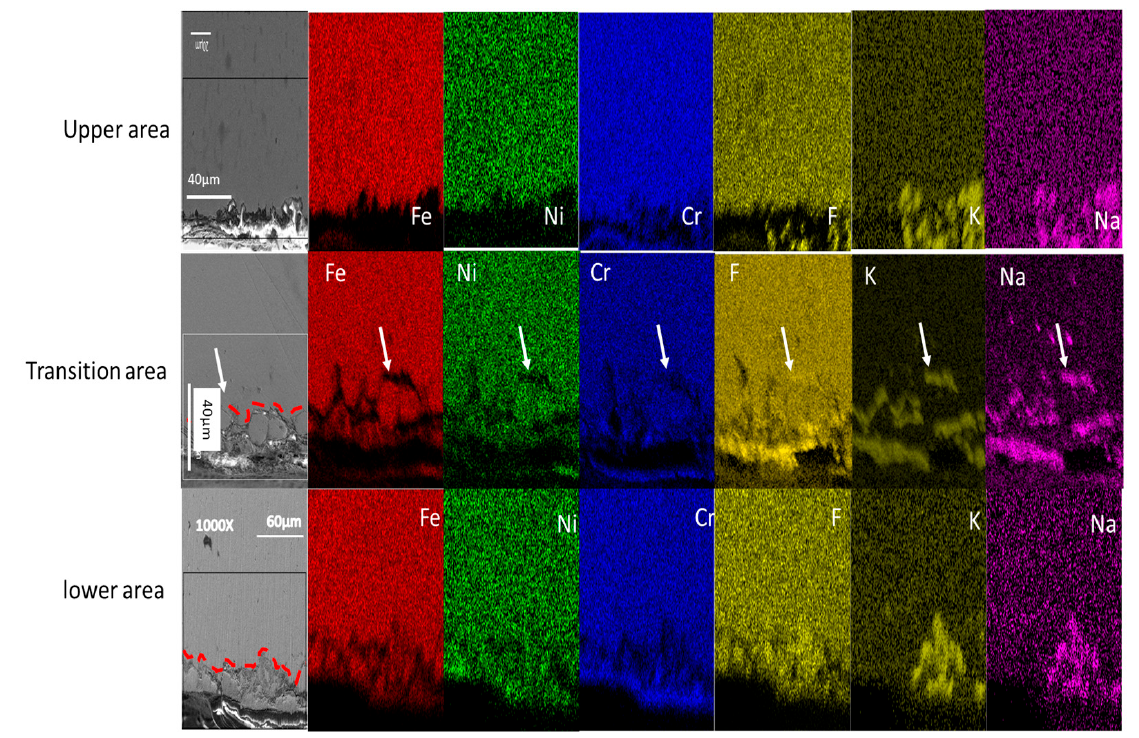
Figure 6. Cross section of SS316L stainless steel with the depth of penetration of the elements into the base metal.